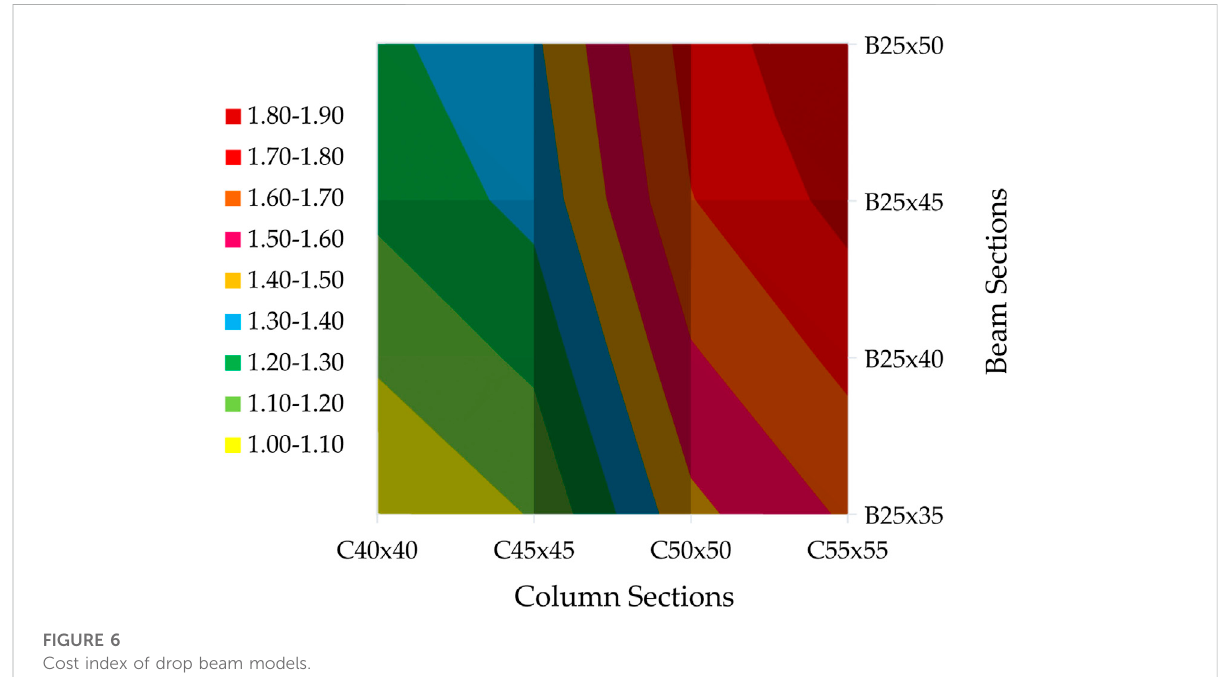
FIGURE 6 Cost index of drop beam models.